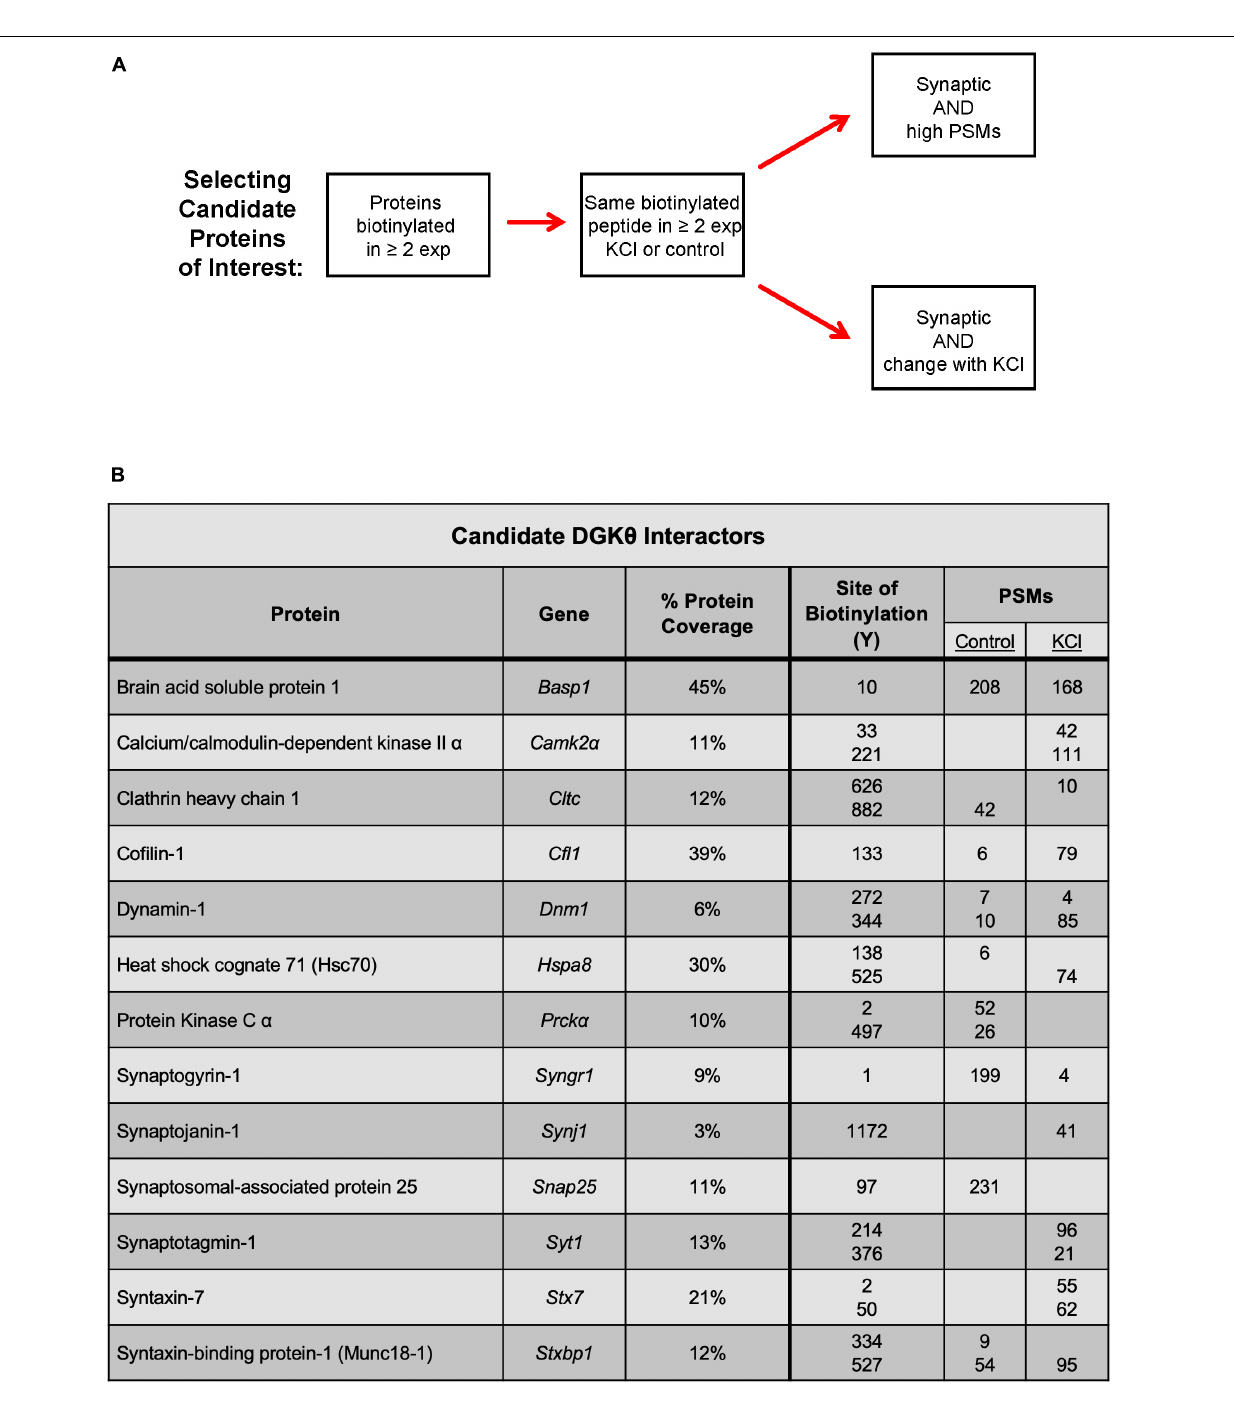
FIGURE 3 | Selection of candidate DGK θ proteins of interest. (A) Criteria for the selection of candidate DGK θ -interacting proteins. (B) The selected candidate DGK θ interactors and one or two biotinylated peptides (all of which were identified in all three mass spectrometry experiments), with their PSMs in each condition. Site of biotinylation, PSMs, and % protein coverage from mass spectrometry experiment